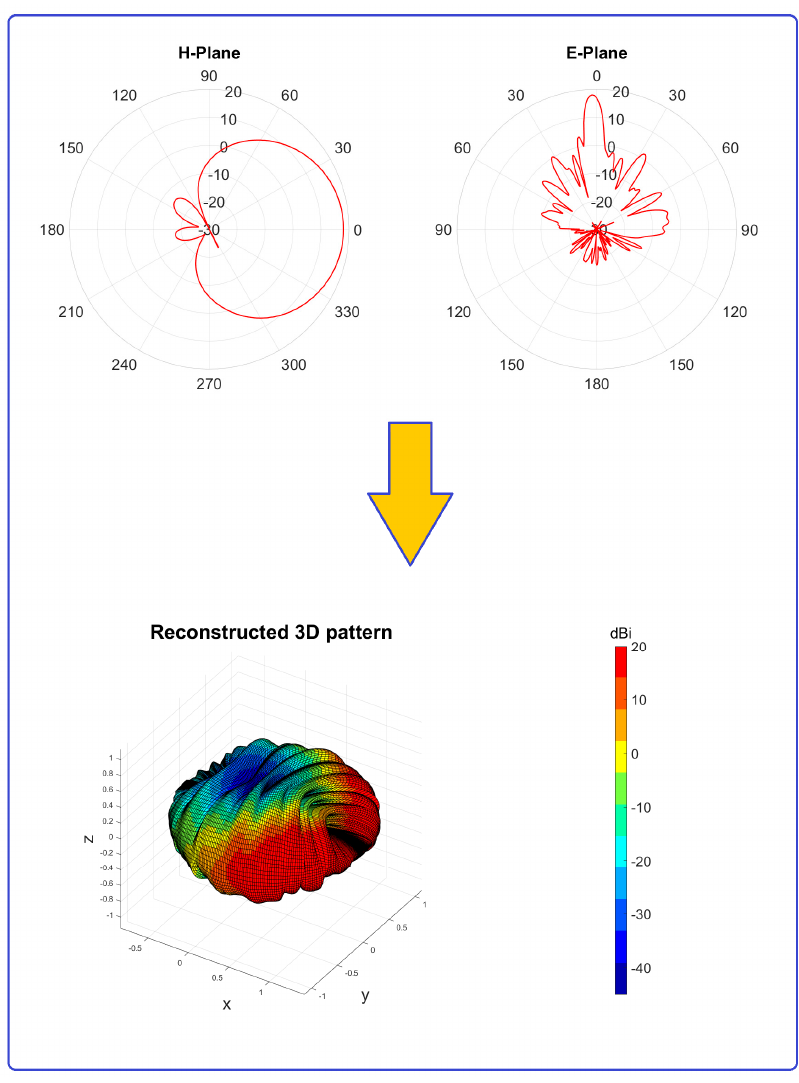
Figure 1. Example of the inputs and output of the algorithm for the 3D reconstruction of the antenna gain [25,26]. The case of the Kathrein 742212 antenna is